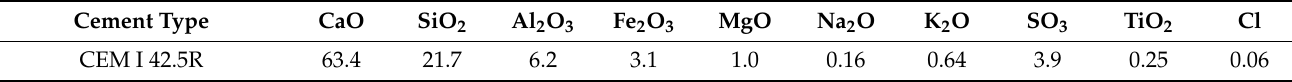
Table 1. Chemical compositions of cement [wt.%].